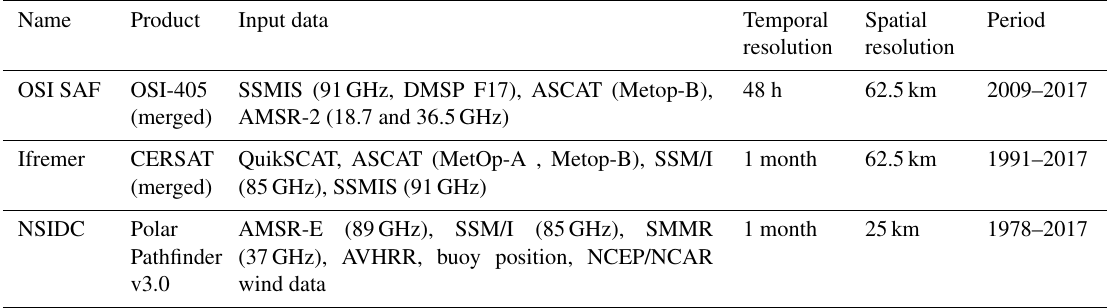
Table 1. Ice drift products used for this